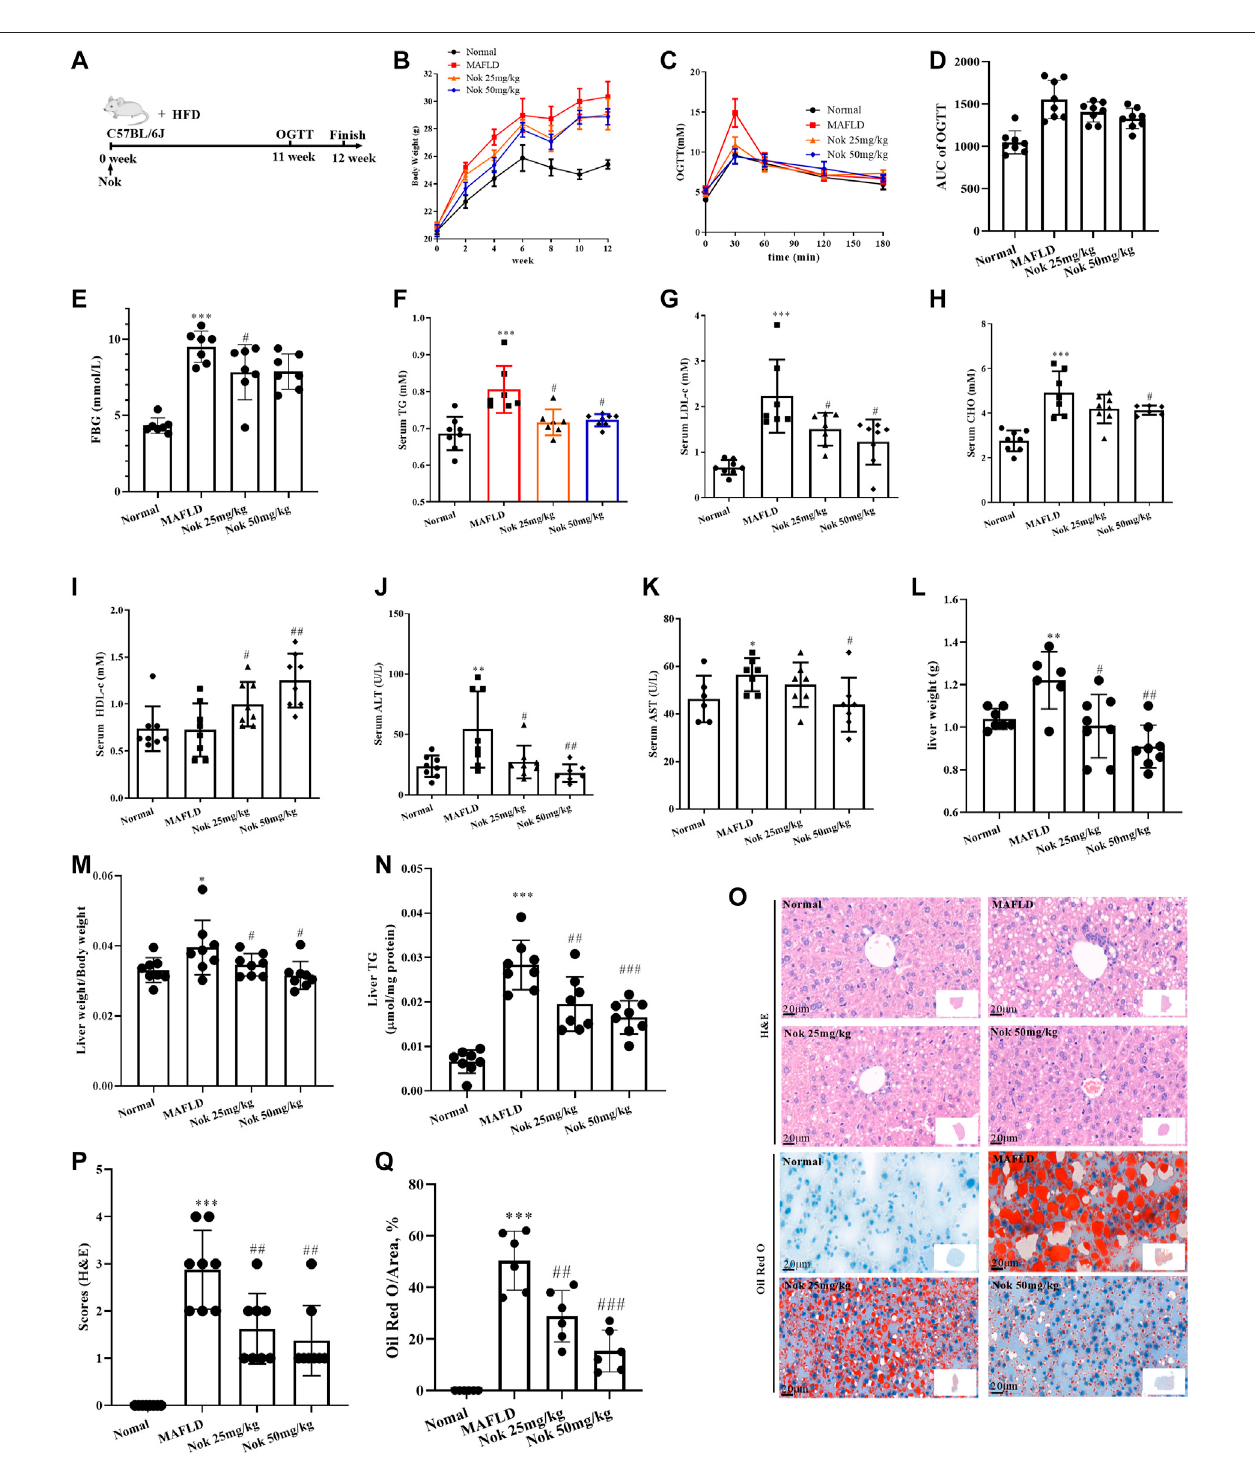
FIGURE2| Nootkatoneameliorated metabolic-associatedfatty liver. Mice fedahigh-fat dietwereadministered Nokat dosesof25 mg kg − 1 and 50 mg kg − 1 daily for 12weeks (A) . Changes in body weight (B) , OGTTtest results at 11 – 12weeks (C) and OGTTAUC (D) , FBG (E) , serum lipid (F – I) , liver function (K – L) ,liverindex (liver weight/body weight, (M) ,liverTG (N) ,and liverhistopathologicalexamination includingH&Eand Oil Redstaining (O) ,grading (P) andquantitybyredareacoef fi cient (Q) were measured. All data points represent the means ± SD (n = 8 per group); * p < 0.05, ** p < 0.01, *** p < 0.001 vs. normal group mice; # p < 0.05, ## p < 0.01, ### p < 0.001 vs. MAFLD group mice.